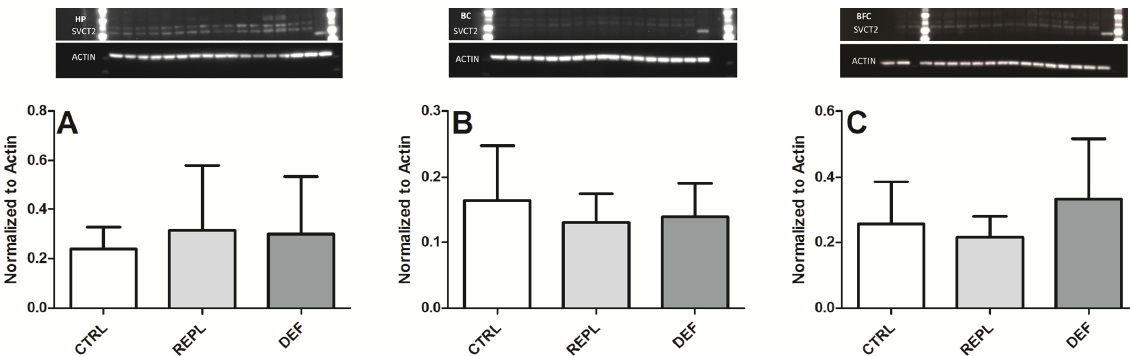
Figure 3. Western blot analysis of SVCT2 protein in brain. Densitometry analysis of western blot analysis of SVCT2 protein levels from three brain regions of guinea pigs HP ( A ); BC ( B ) and BFC ( C ); CTRL: control group, REPL: repleted group and DEF: deficient group. Representative pictures of the blots are depicted above each bar graph. Values are displayed as mean of normalized ratio to actin ± SD, the exact SVCT2 densitometry mean values (±SD) are provided in Table